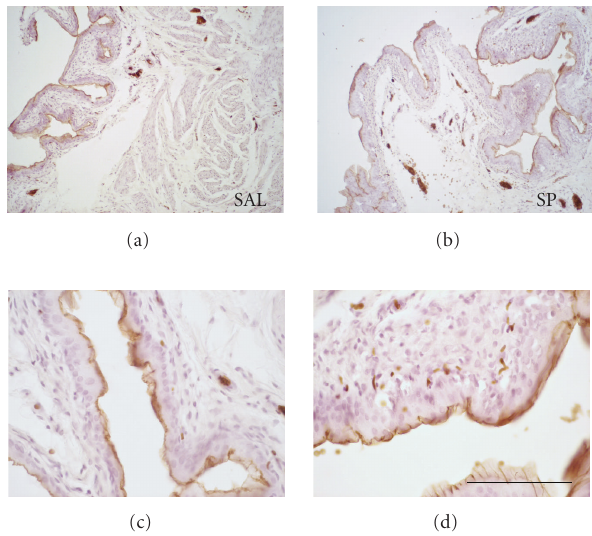
Figure 1: In vivo biotinylation of urothelium. (a) and (c) saline- treated bladders, (b) and (d) SP-treated bladders. Biotin labeling is determined only with strepavidin-HRP and is localized to surface urothelium. Calibration bar—(a), (b) = 400 μ m; (c), (d) = 100 μ m.